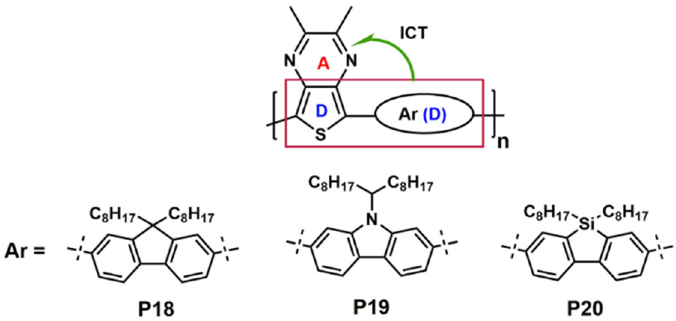
Figure 7. ICT interaction of P18 to P20 .